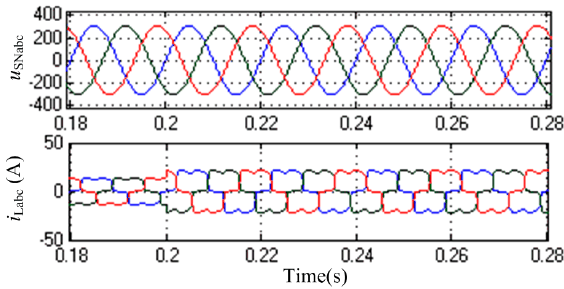
Figure 9. Grid voltages and nonlinear load currents with step change. Energies 2017 , 10 , 112